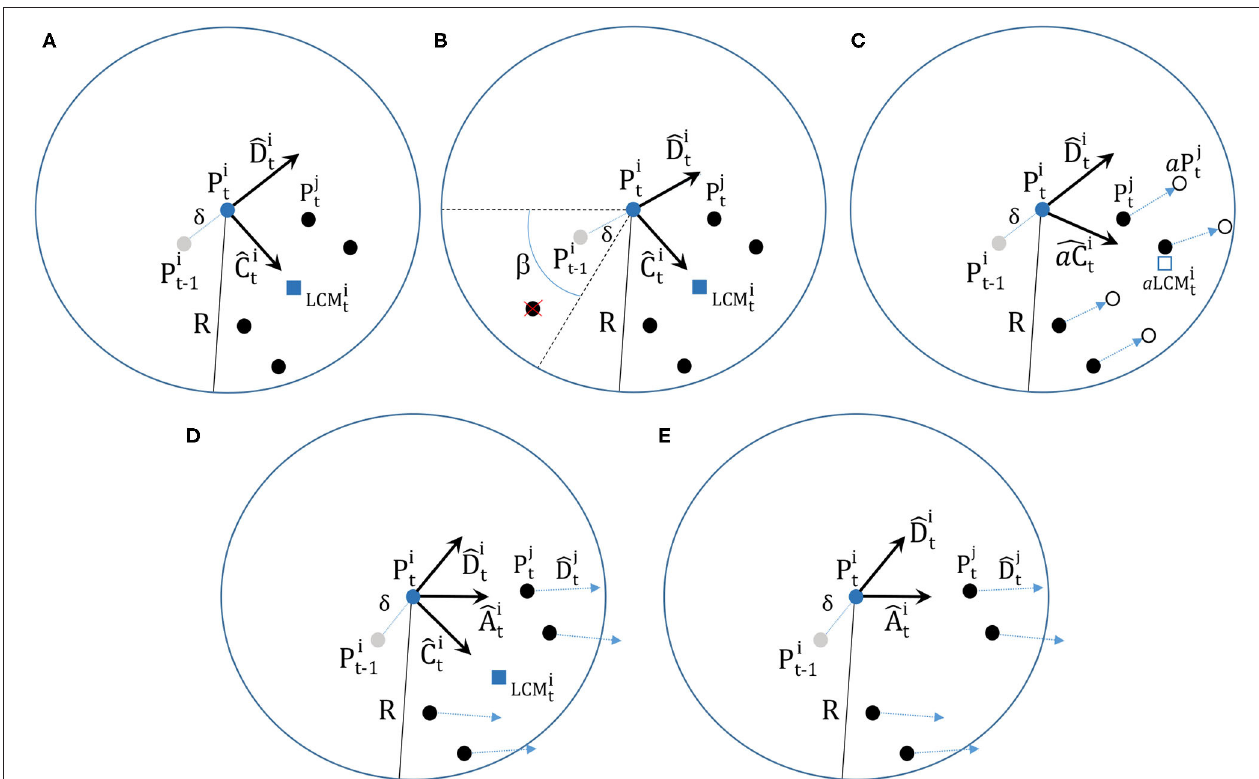
FIGURE 1 | The interactions in the models. In each model a focal particle is located at position P i t at the center of the interaction zone with radius R and the black filled circles represents the (potential) neighbors. In the preceding timestep the focal particle moved a distance of δ from its previous position P i t − 1 and its current heading is ˆ D i t . (A) The local attraction model (LAM). The focal particle calculates the position of the local center of mass of its neighbors ( LCM i t ) and sets up the normalized vector ˆ C i t pointing towards it. This describes the interactions in models (I,III,V,VI) and these differ only in how the update is executed. (B) LAM with blind zone (II). Same as in (A) except that any neighbors that are located in the blind zone specified by the angle β are not included in the LCM i t and ˆ C i t calculations. Here, there are five particles within the interaction range R in the figure, but one of them is in the blind zone and therefore excluded from the LCM calculation. (C) LAM with anticipation (IV). Here, the focal particle calculates the anticipated local center of mass ( aLCM i t ) and the anticipated attraction vector ˆ aC i t using the anticipated future positions of its neighbors (open circles) rather than their current positions (black filled circles). The future anticipated position of neighbor j , currently at position P j t , is aP j t = P j t + τδ ˆ D i t , that is, the position that neighbor would be at if it continued with its current heading at its current speed δ for a time τ (the anticipation time). (D) LAM with explicit alignment (VII). Here, the focal particle calculates the local center of mass and set up the ˆ C i t vector like in (A) , but it also sets up a normalized vector ˆ A i t which is the average heading of its neighbors. (E) Explicit alignment only (VIII). Here, the focal particle only sets up the ˆ A i t vector, there is no attraction. Figure (A) is from [ 16] (CC-BY Strömbom), Figure (C) is from [17] (CC-BY Strömbom), and (B,D,E) have been adapted from